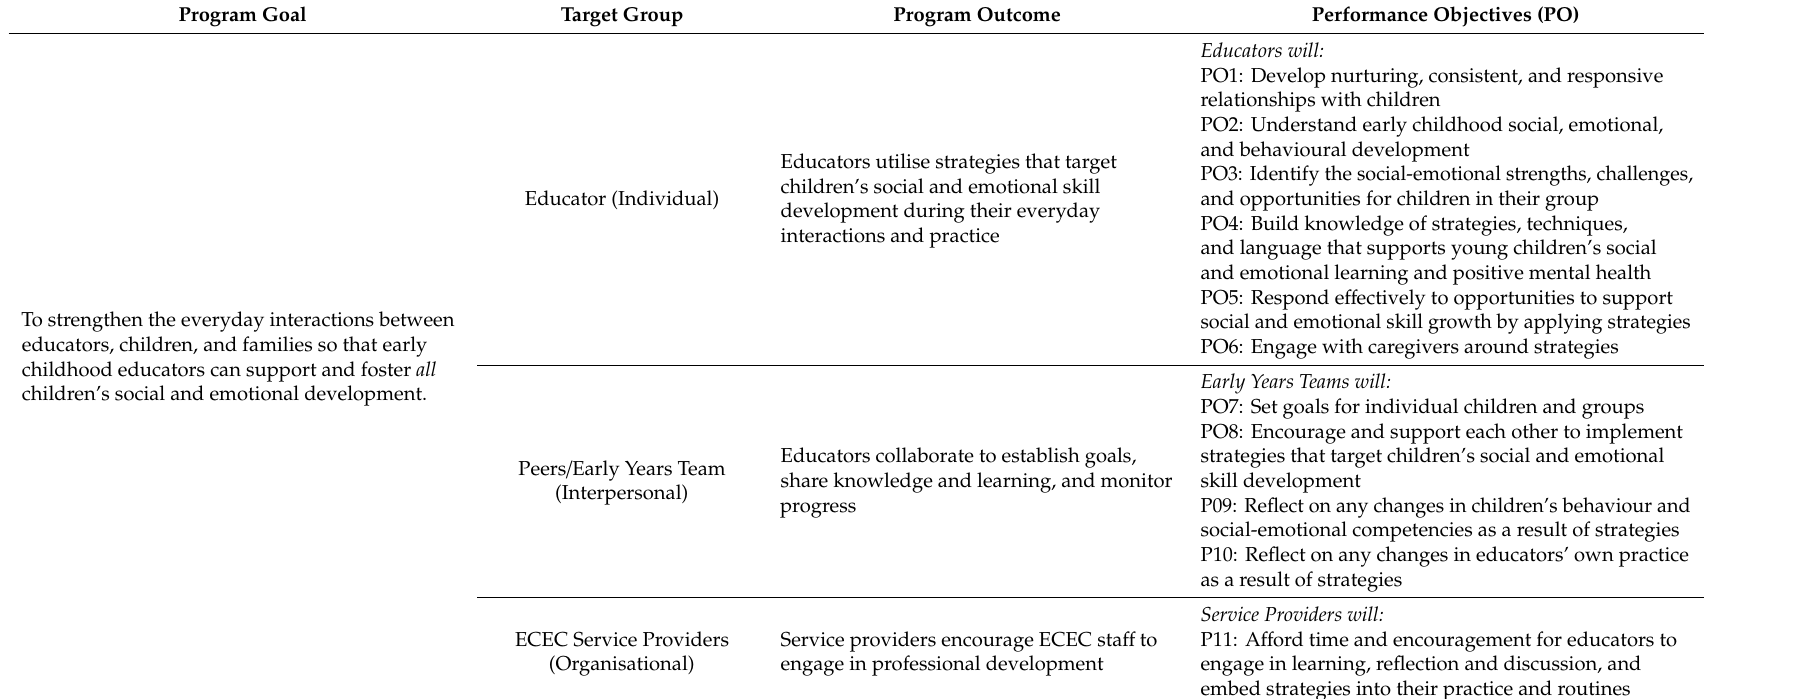
Table 2. Program Outcomes and Performance Objectives for Cheshire SEED by Socio-Ecological